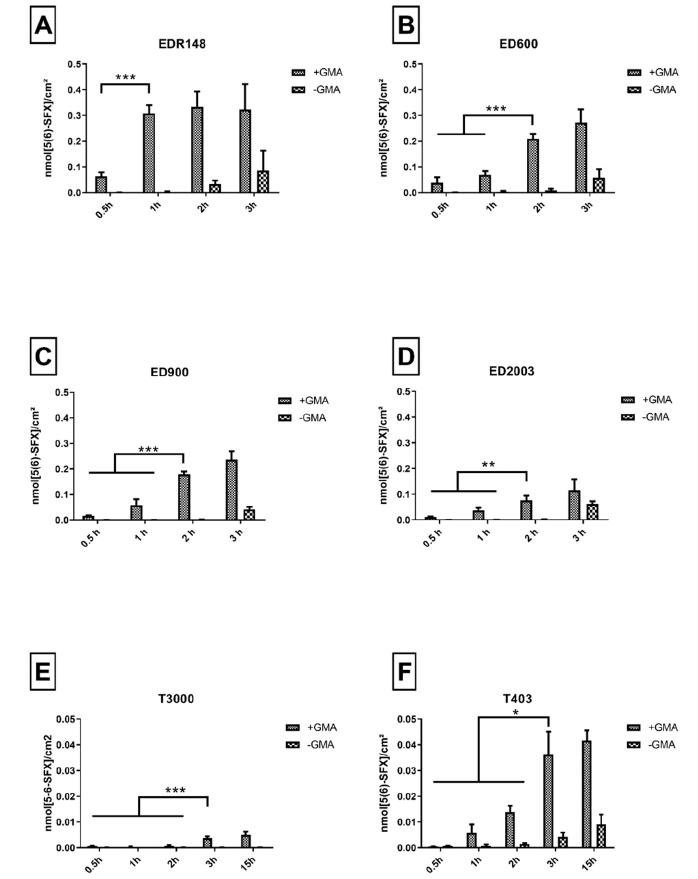
Figure 2. Immobilized 5(6)-SFX indicating the amount of accessible, derivatizable amino groups on film surface. Values measured on the film surface after cross-copolymerization with and without GMA and subsequent incubation with di ff erent linker molecules over varying periods. ( A – D ) represent the results for two-armed, ( E , F ) for three-armed polyetheramine-based linker molecules applied. All values represent the mean ± SD of n ≥ 4. * p < 0.05; ** p < 0.01; *** p < 0.001 denotes significant di ff erence vs. the respective treatment.